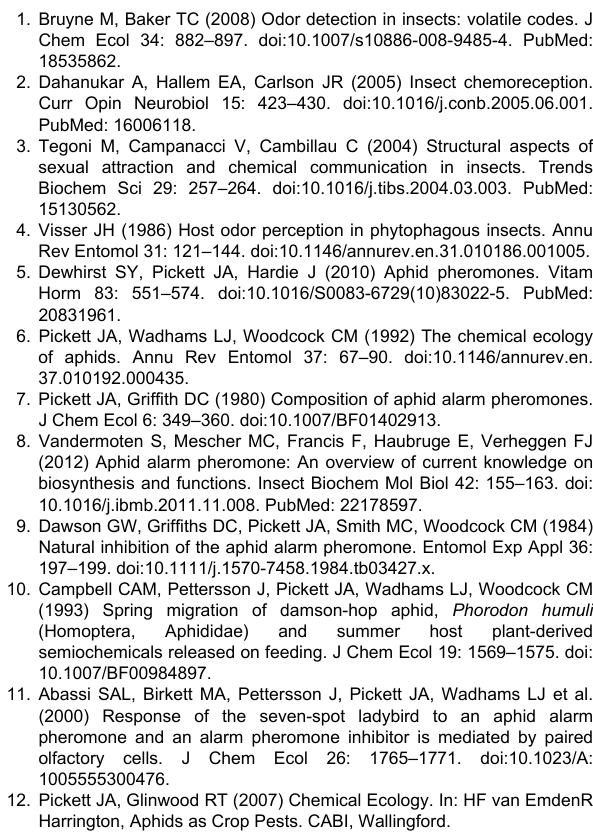
Figure S1. Alignment of the A. gossypii OBPs. Full-length amino acid sequences of AgosOBP2-10 were aligned by ClustalX 2,1. Green boxes show conserved cysteine residues.